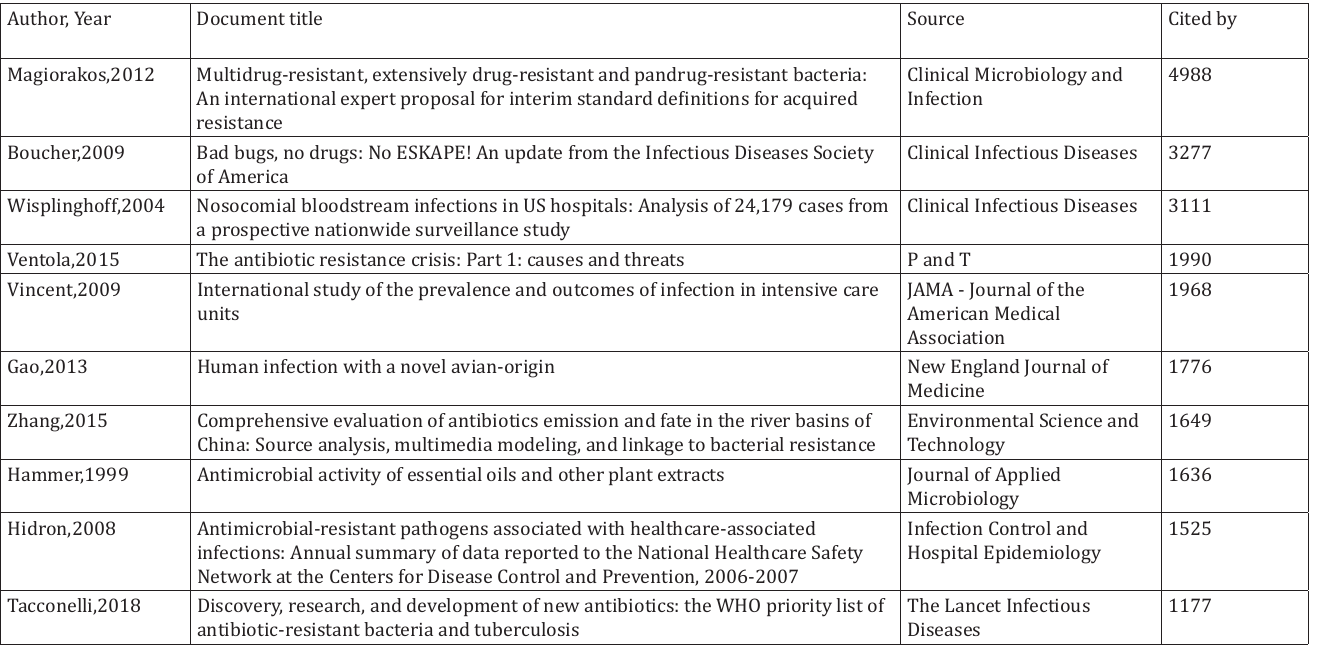
The List of Most Cited Publications on